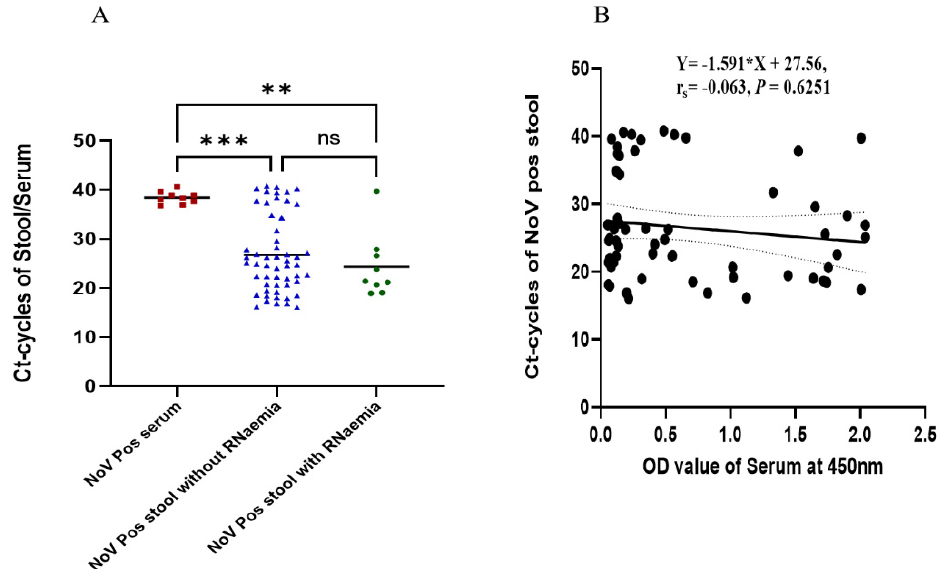
Figure 1. Viral load estimation from RT-qPCR and its correlation with NoV-Ag levels in serum and stool samples. ( A ) The red square dots represent positive serum samples, the dotted blue triangles represent positive stool samples without RNA present in their serum, and the circular green dots represent positive stool samples with RNA present in the serum. ( B ) Correlation between positive stool and antigenemia based on serum OD at 450 nm. ** p < 0.01, *** p < 0.001.